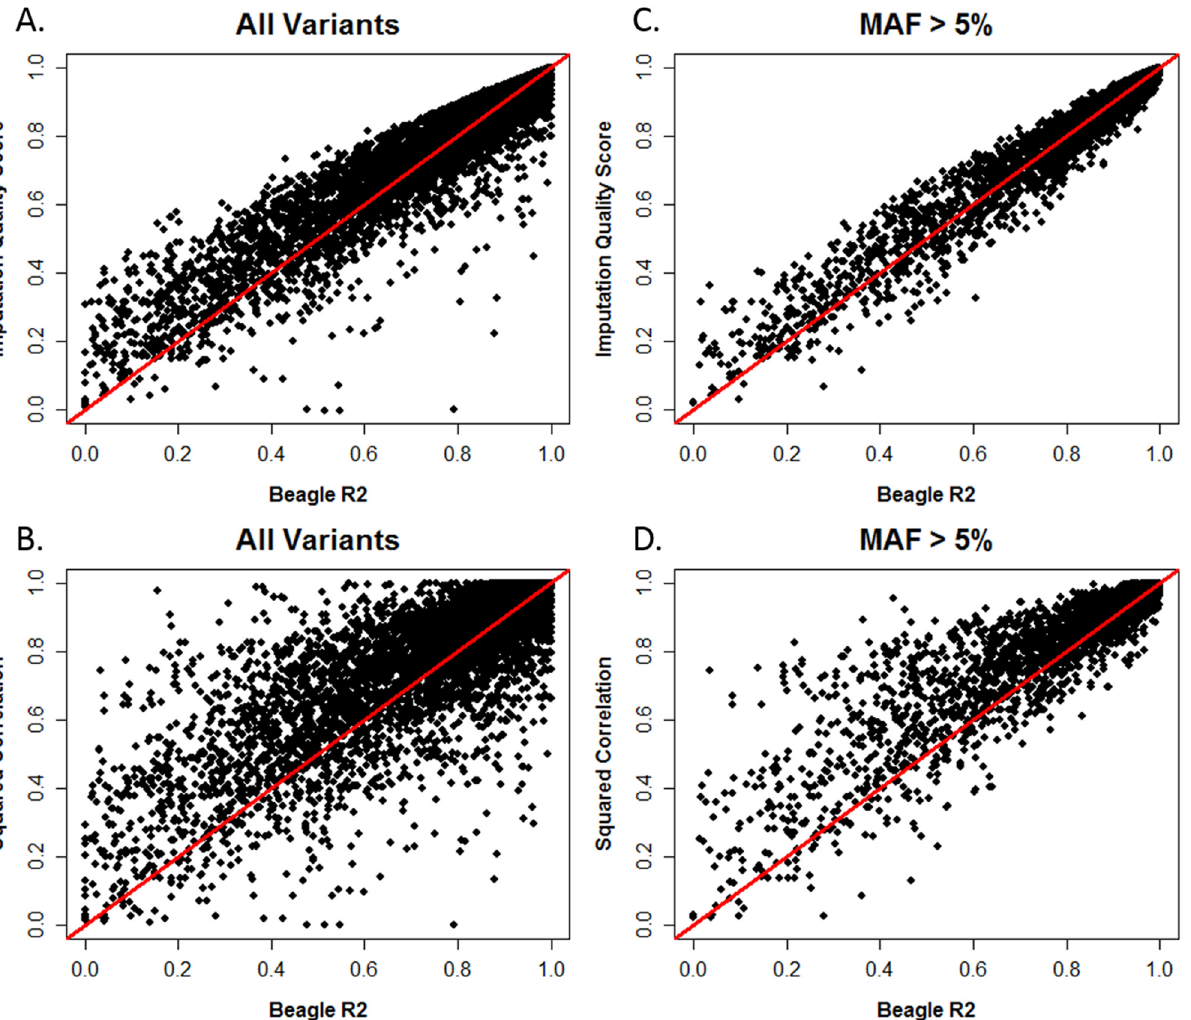
Fig 5. Scatterplots of IQS, squared correlation, and BEAGLE R 2 . Panels A and B display all 13,442 variants, and panels C and D display variants with MAF > 5% (N = 6,480). The line y = x is denoted in